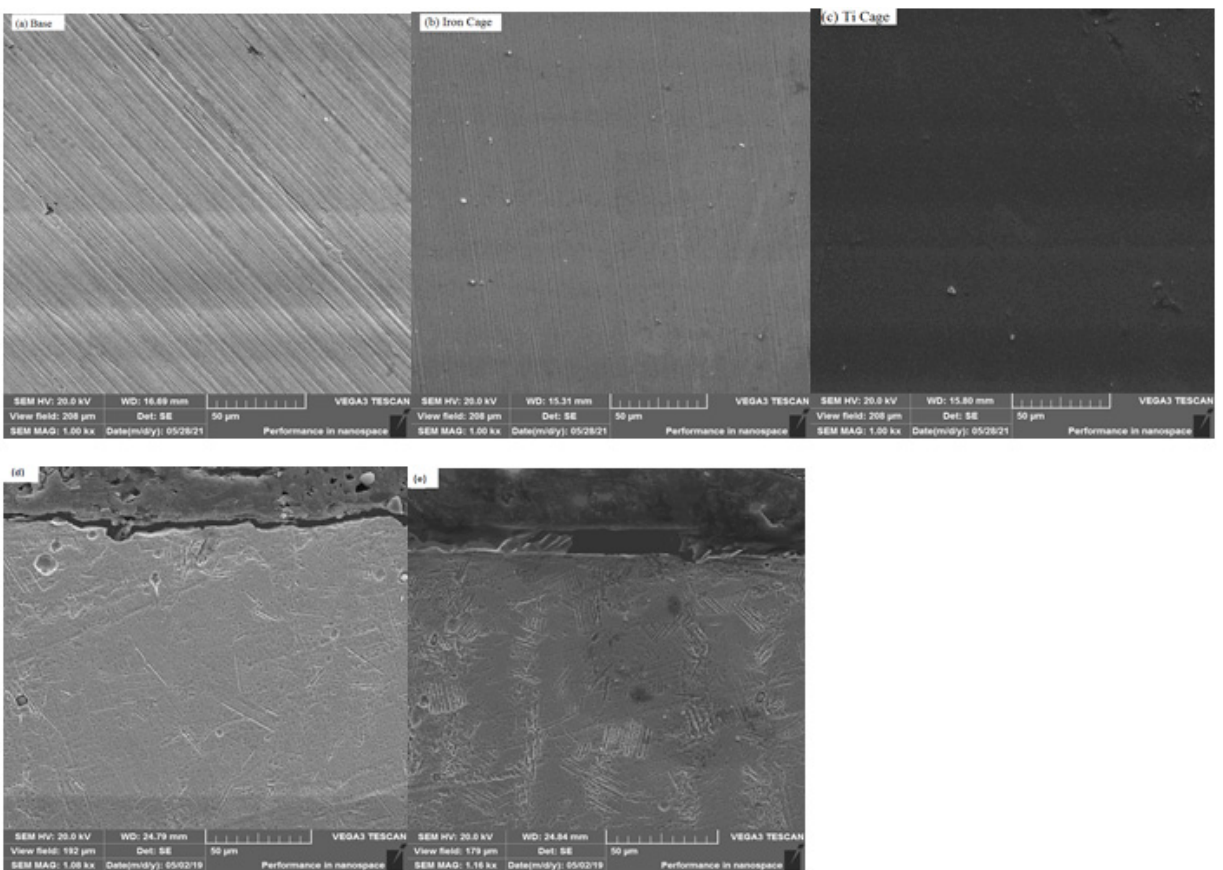
Figure 3. Scanning Electron Micrographs of ( a ) base ( b ) ASS CC ( c ) Ti CC whereas ( d ) ASS CC and ( e ) Ti CC cross-sectional images.